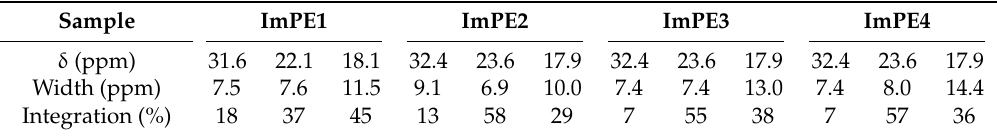
Table 3. Parameters used for the simulation of 31 P MAS NMR spectra of γ -Al 2 O 3 grafted with ImPE under either standard (ImPE1) or forcing (ImPE2, ImPE3 and ImPE4) reaction conditions. Sample ImPE1 ImPE2 ImPE3 ImPE4 δ (ppm) Integration